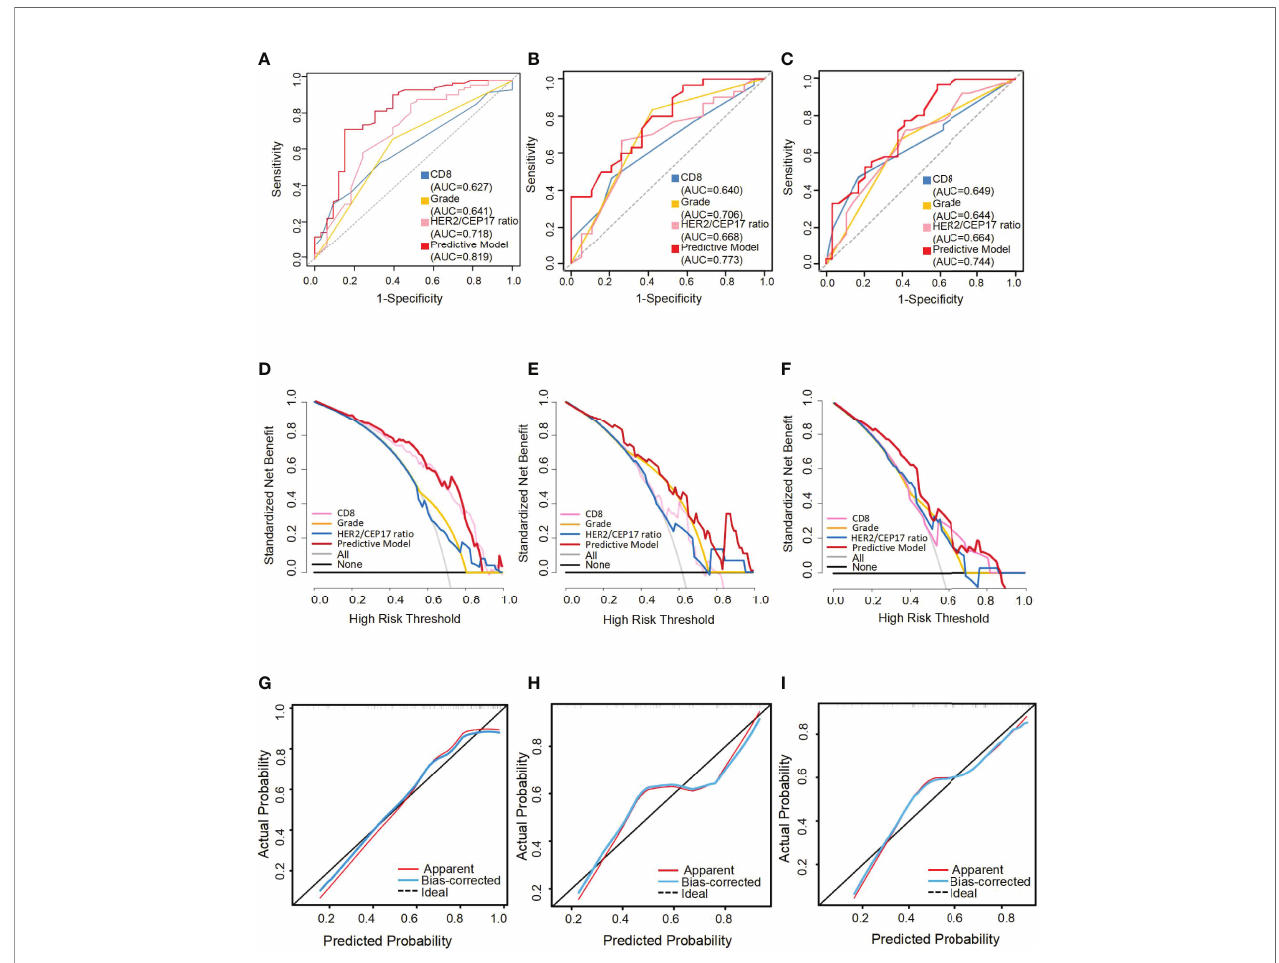
FIGURE 4 | The receiver operating characteristic (ROC) curves, decision curve analysis (DCA), and calibration curve for the predictive nomogram model in the training set, testing set, and external validation set. AUC, area under the curve. The ROC curves of the training set (A) , the testing set (B) , and the external validation set (C) . Decision curve analysis (DCA) of the training set (D) , testing set (E) , and external validation set (F) . Calibration curve of the nomogram in the training set (G) , the testing set (H) , and the external validation set (I)